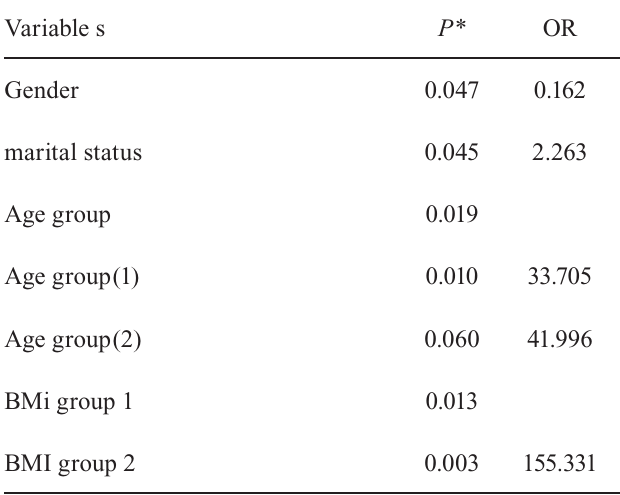
TABLE IV - Multiple logistic regression analysis of potential risk factor for metabolic abnormalities